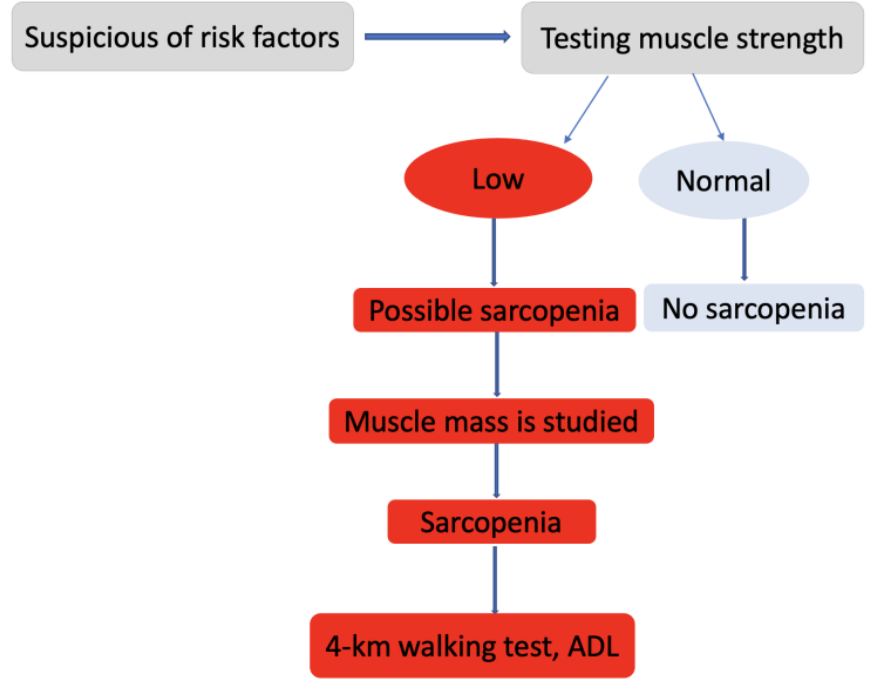
Figure 2. Diagnostic algorithm for sarcopenia in the elderly (EWGSOP). ADL, daily activity living. The SARC-F questionnaire contains five questions assessing strength, gait, transfer from chair or bed, stair climbing, and falls [22]. It is considered one of the best tools high specificity but low sensitivity for classification of sarcopenia [23]. Each component is scored from 0 to 2 points, giving an overall SARC-F score between 0 and 10 points (Table 1). Table 1. SARC-F